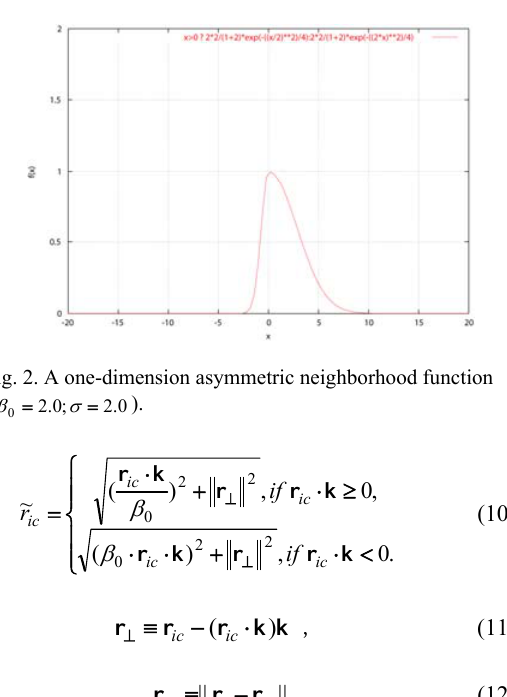
Fig. 1. GSOM: Insert a new row or column between the BMU c and the farthest unit f among neighbors of c